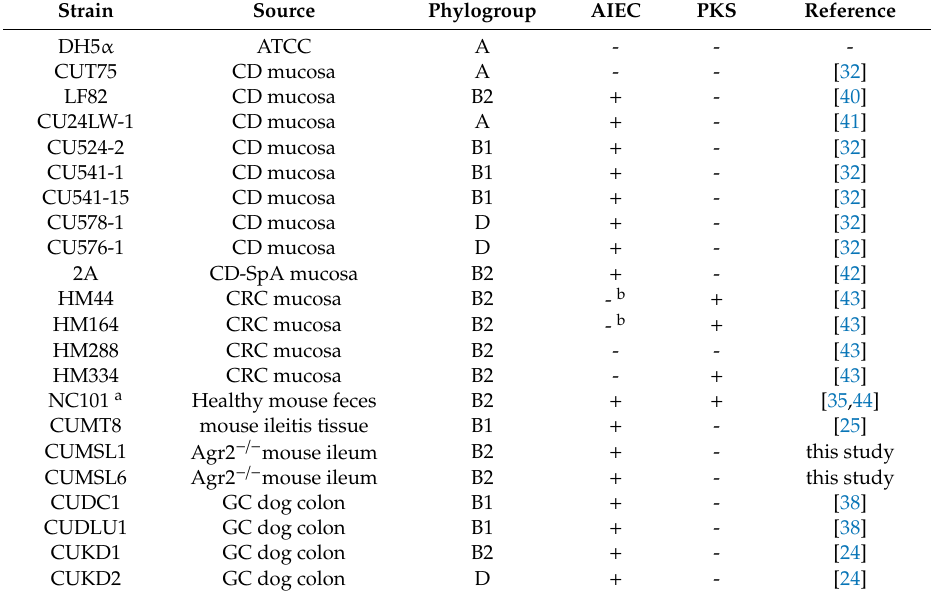
Table 2. E. coli strains used in the